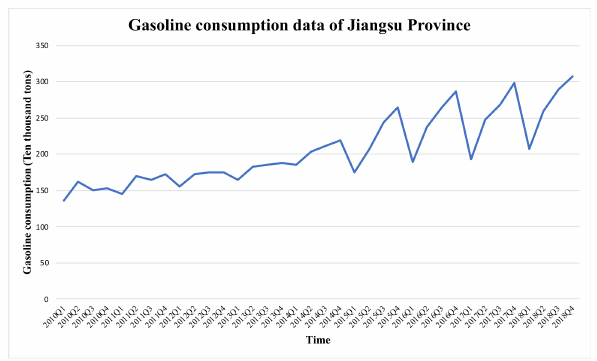
Figure 3. Gasoline consumption data of Shandong Province.